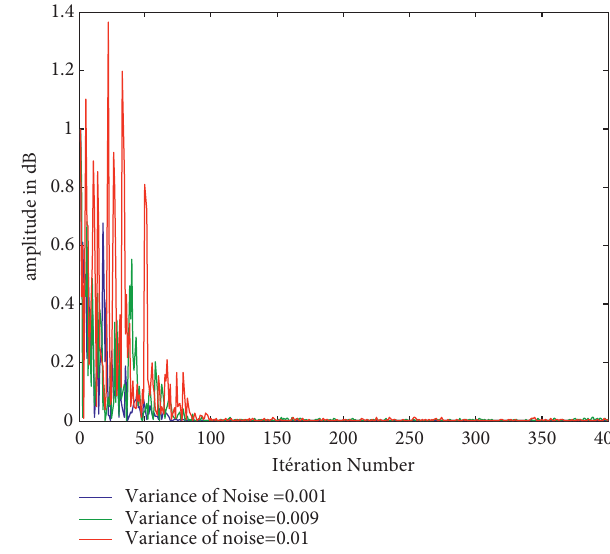
Figure 6: Magnitude of error vs iteration number (CM).